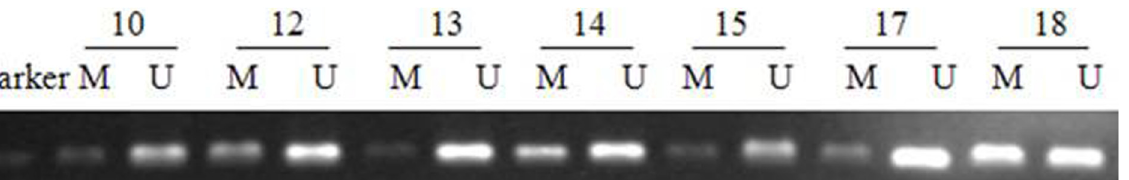
Fig 2. Representative Zic1 promoter methylation, as determined by methylation-specific polymerase chain reaction (MSP) assay. M: Methylation- specific primers; U: Unmethylated-specific primers.